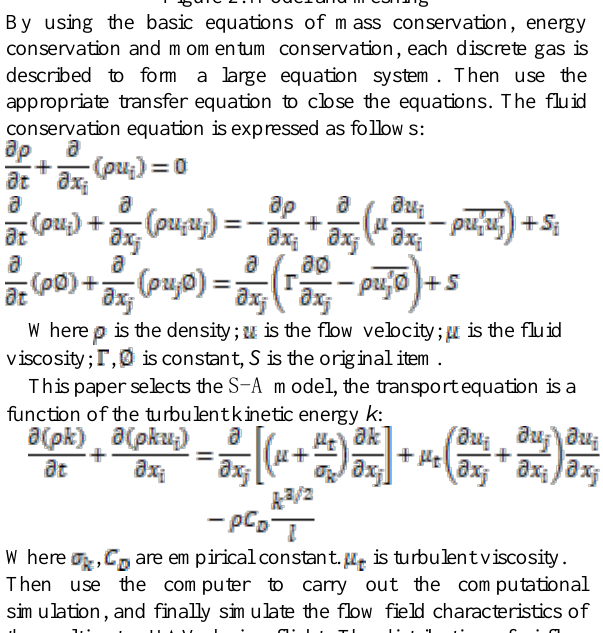
Figure 1. Multi-rotor drones of different structures In general, the trend is shown in Table 1. Table 1. Trends of stability and flexibility,